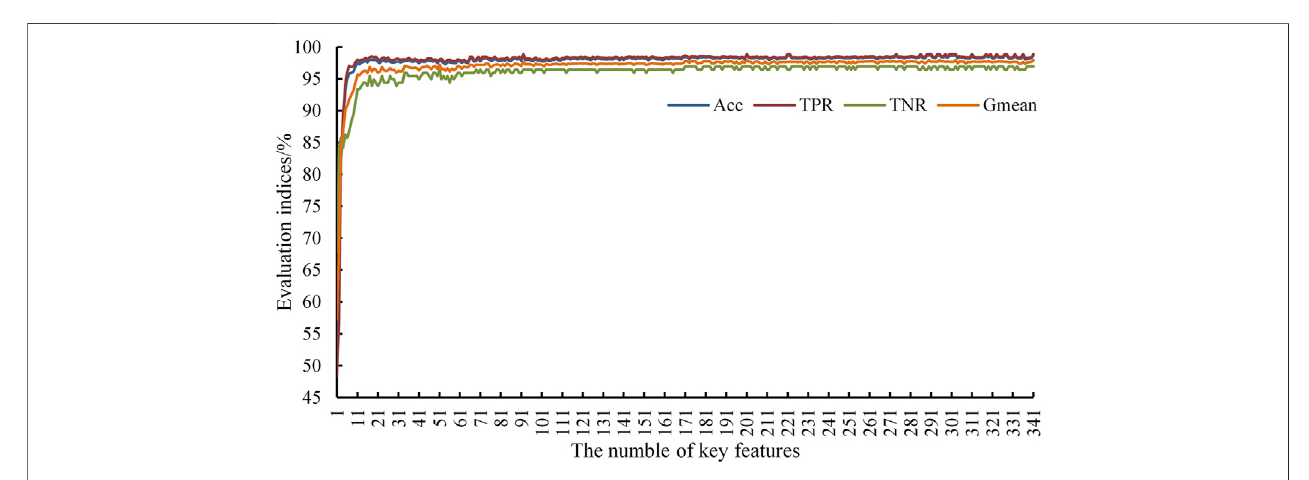
FIGURE 6 | Impact of the number of key features on classi fi cation performance.